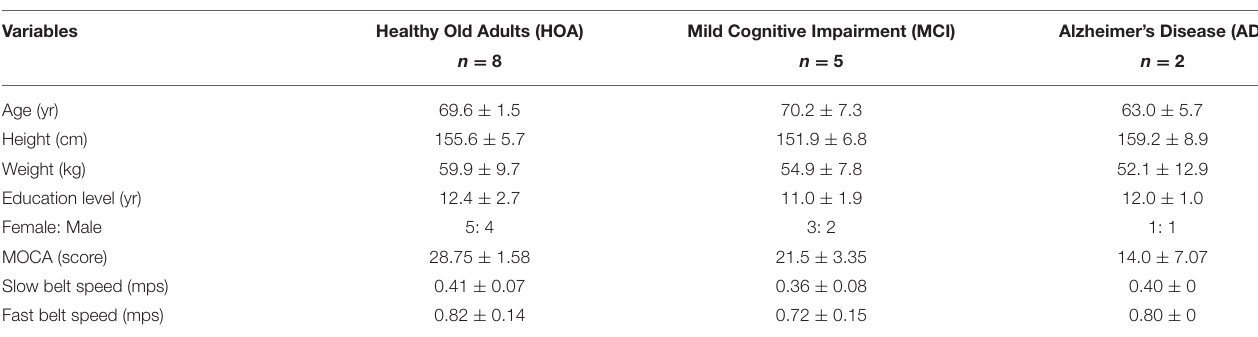
TABLE 1 | Participant